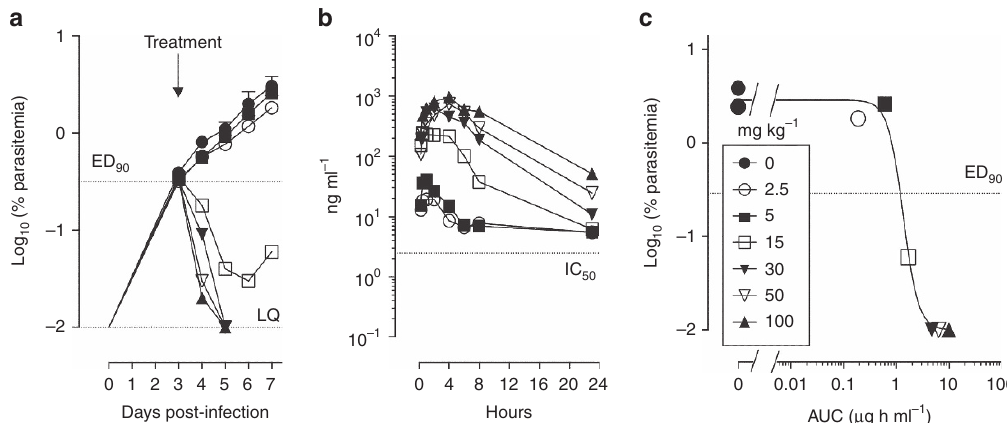
Figure 4 | Efficacy of E209 in the in vivo -humanized SCID mouse model of P. falciparum . ( a ) Parasitemia in peripheral blood of NSG mice infected with the P. falciparum strain 3D7 0087/N9 ( n ¼ 2 mice treated with vehicle and n ¼ 6 mice treated with E209). ( b ) Blood levels of E209 in the efficacy experiment shown in a over the first 24h post-dosing. ( c ) dose/exposure–response